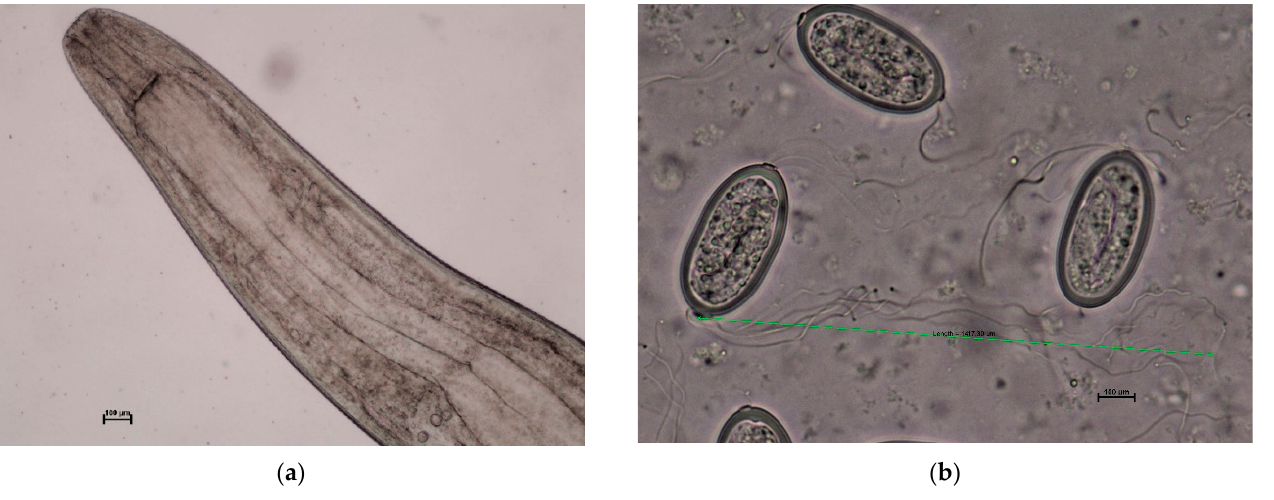
Figure 2. Cystidicola farionis ; ( a ) anterior region of an adult female (scale bar 100 μ m); ( b ) Eggs removed from the uterus provided with characteristic filaments (scale bar 100 μ m).